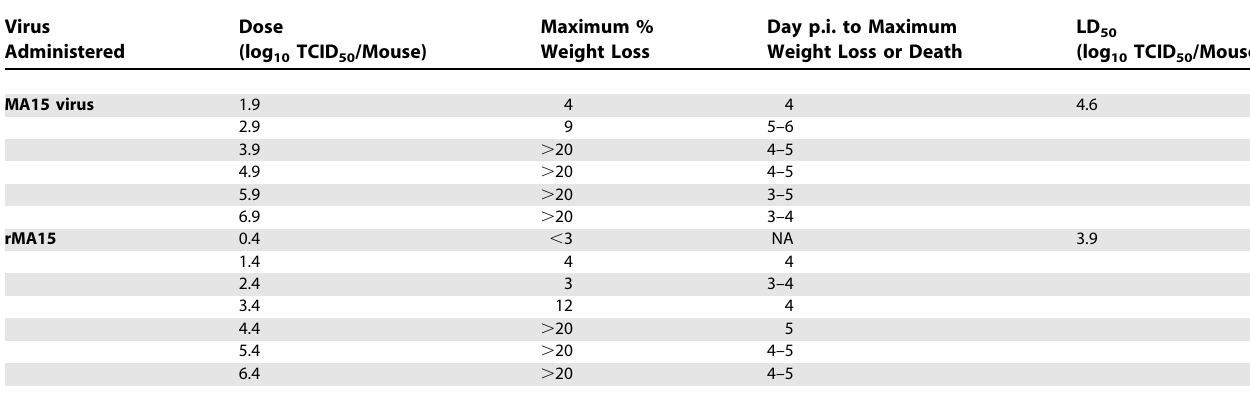
Table 1. Morbidity and Mortality in Mice following Intranasal Administration of MA15 and Recombinant MA15 Viruses Virus Administered